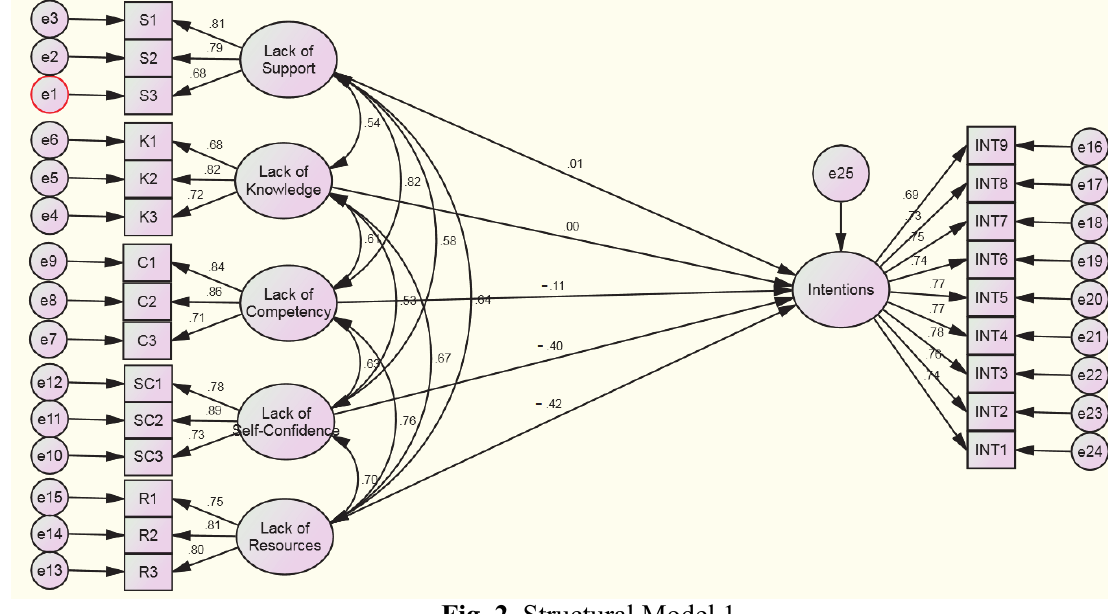
Fig. 2. Structural Model 1